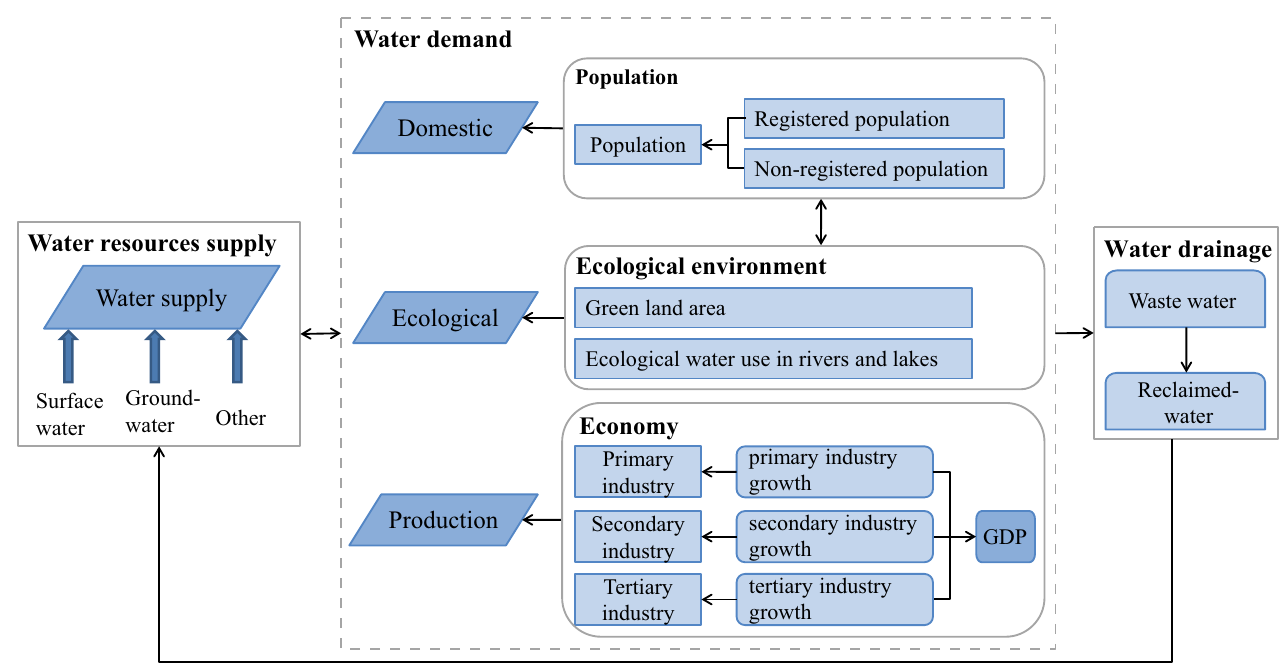
Fig 1. Diagram of the water cycle in each